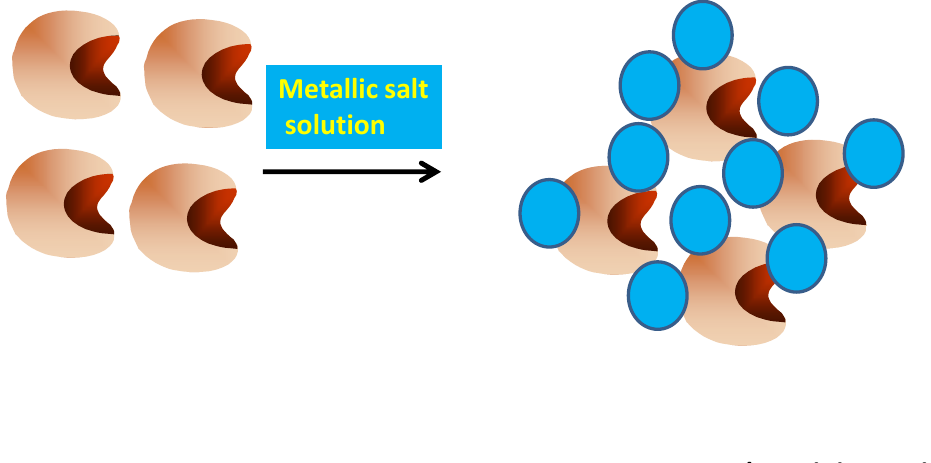
Figure 4. Preparation of metal-enzyme